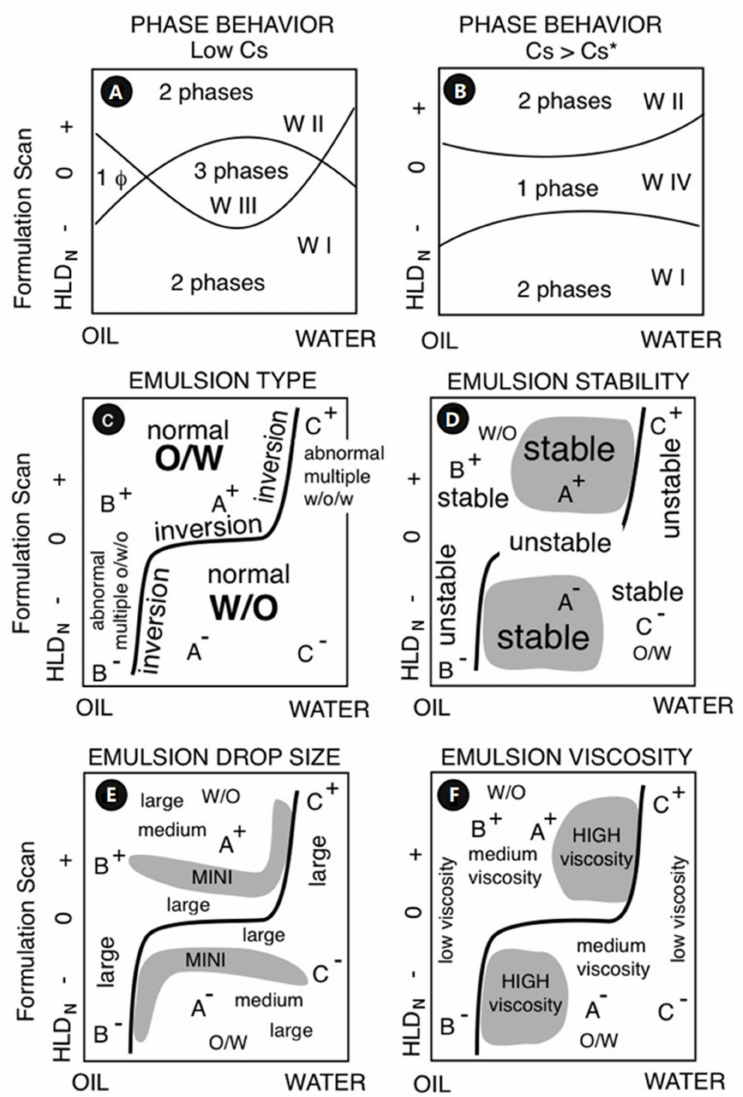
Figure 15. Phase behavior and emulsion properties on the formulation-WOR space at constant surfactant concentrations for a pure surfactant